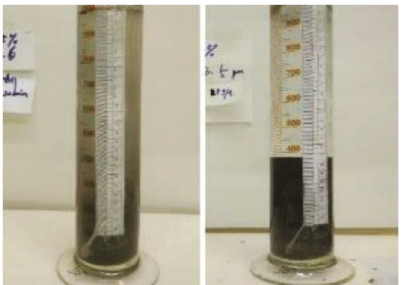
Figure 2: Comparison of natural settling and flocculation